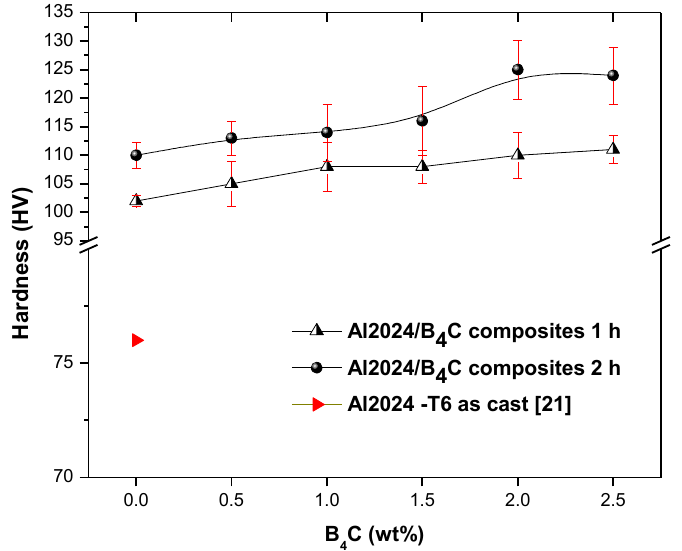
Figure 6. Effect of the B 4 C content and milling time on the microhardness of the Al2024/B 4 C